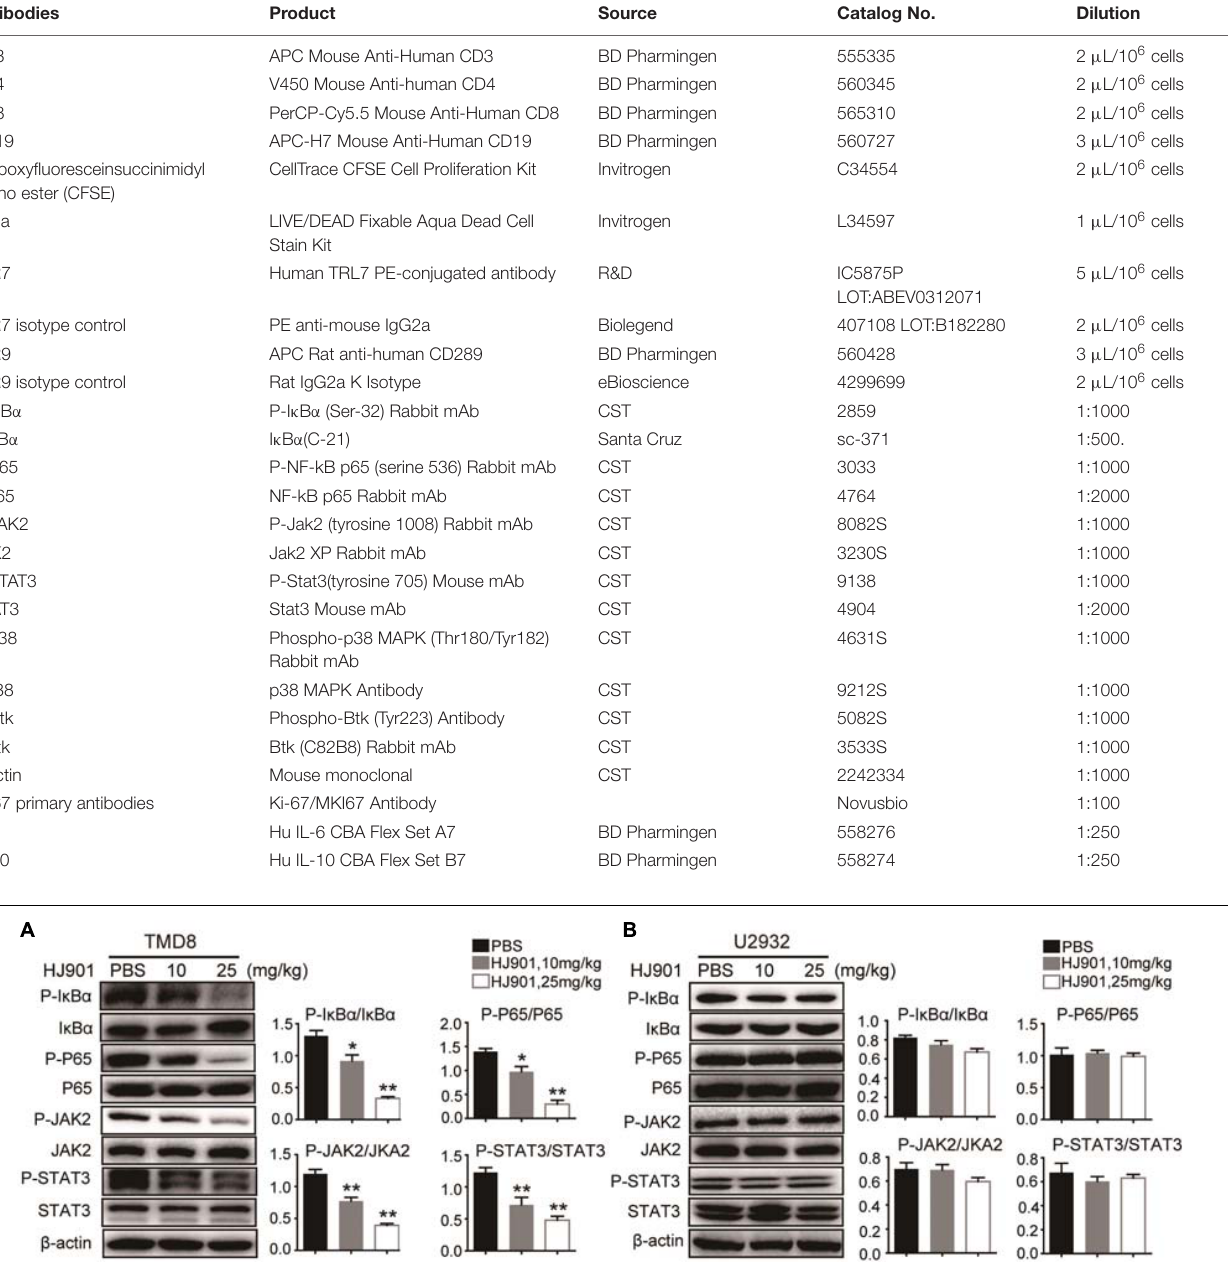
FIGURE 7 | Suppressive effect of HJ901 on NF- κ B and JAK2-STAT3 pathways in vivo . Mice with TMD8 or U2932 xenografts were treated with or without HJ901 (10 or 25 mg/kg). Tumor tissues were collected and analyzed by western blotting. Tumor tissues from TMD8 (A) and U2932 (B) xenografts mice with or without HJ901 treatment were collected and analyzed for the expression of P-NF- κ B/NF- κ B, P-I κ B α /I κ B α , and P-JAK2/JAK2, P-STAT3/STAT3 by western